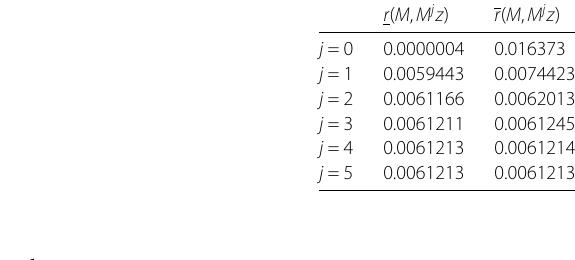
with r 0 = r 1 = r 2 = r 3 = r 4 =